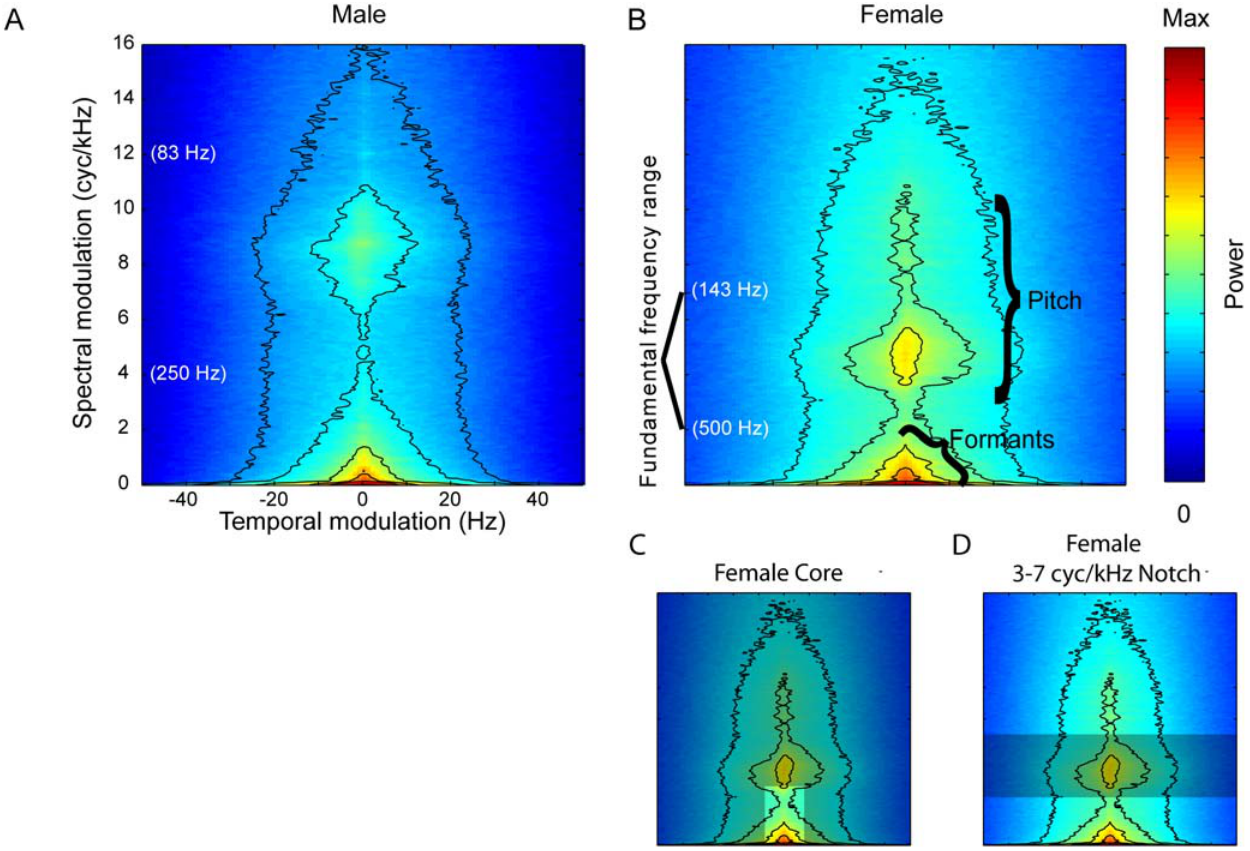
Figure 2. Spectral modulations differ in male and female speech. (A,B) The MPS of the 50 corpus sentences spoken by males (A), and of the 50 spoken by females (B), with black contour lines as in Figure 1. White parenthetical labels on the y-axes of (A) and (B) show related frequencies demarcating the male and female vocal registers; they correspond to spectral modulations based on harmonic spacing. (C,D) Modulation filters that resulted in misidentification of the speaker’s gender. (C) the speech MPS for female speakers is overlapped with the boundaries of the low-pass spectrotemporal filter. In this condition, speaker gender was misidentified in a quarter of the sentences, with 91% of those errors being females misidentified as male. (D) the same female speech MPS overlapped with a notch filter that removed modulations from 3 to 7 cycles/kHz. Of the 21% gender errors in this condition, 95% were female speakers misidentified as male.